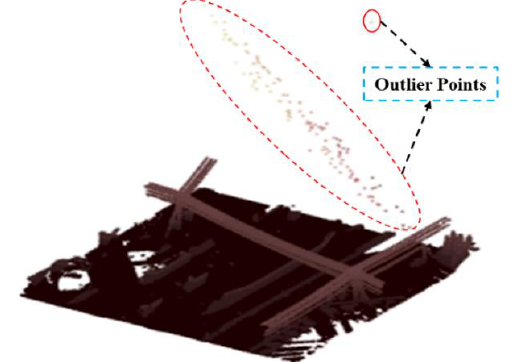
Figure 4. Identifying noisy points with abnormal altitude.